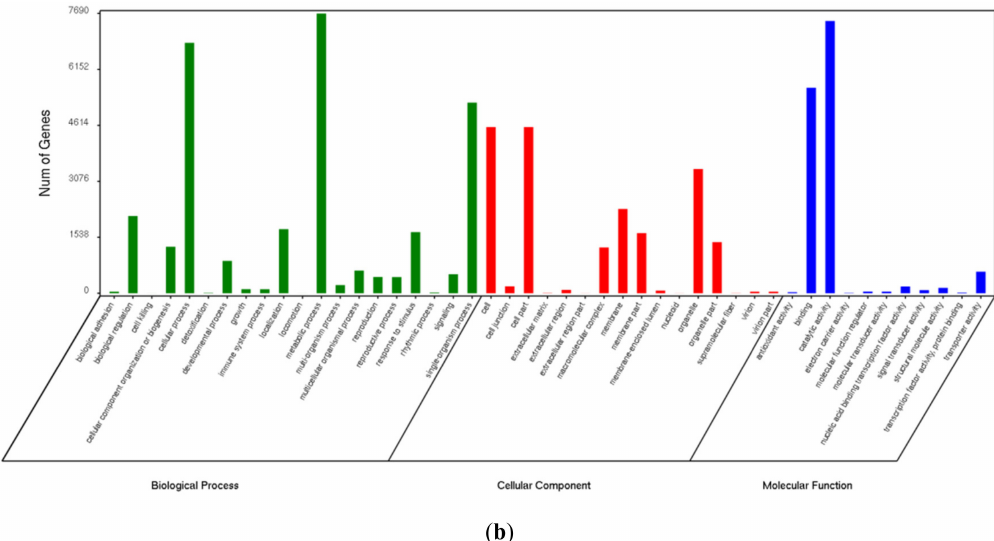
Figure 2. KEGG and gene ontology (GO) analysis of unigenes. ( a ) The KEGG annotation statistics of unigenes; Different colors represent KEGG A Class: Cellular Processes (red), Environmental Information Processing (orange), Organismal Systems (yellow), Genetic Information Processing (green), and Metabolism (blue); ( b ) The level 2 GO functional classification of unigenes; Different colors represent three main ontology terms: Biological Process (green), Cellular Component (red), and Molecular Function